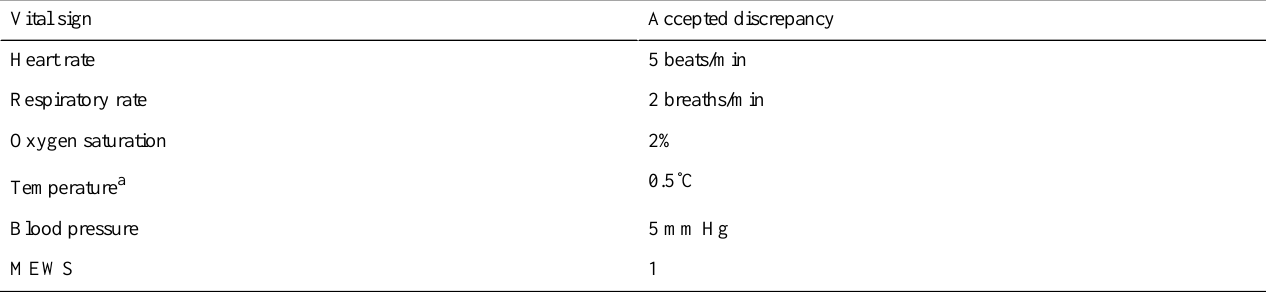
Table 1. Accepted discrepancies between nurse measurements, ViSi Mobile, and